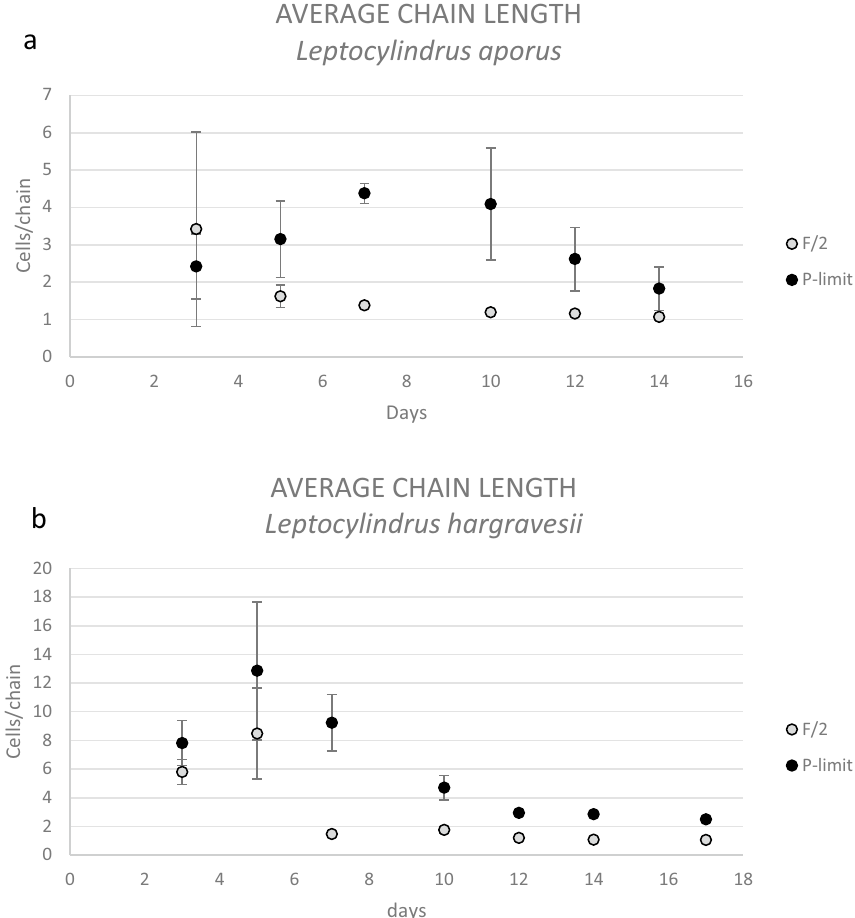
Figure 10. Average chain lengths in F/2 and P-limit medium for L. aporus ( a ) an L. hargravesii ( b ) during 17 days of the